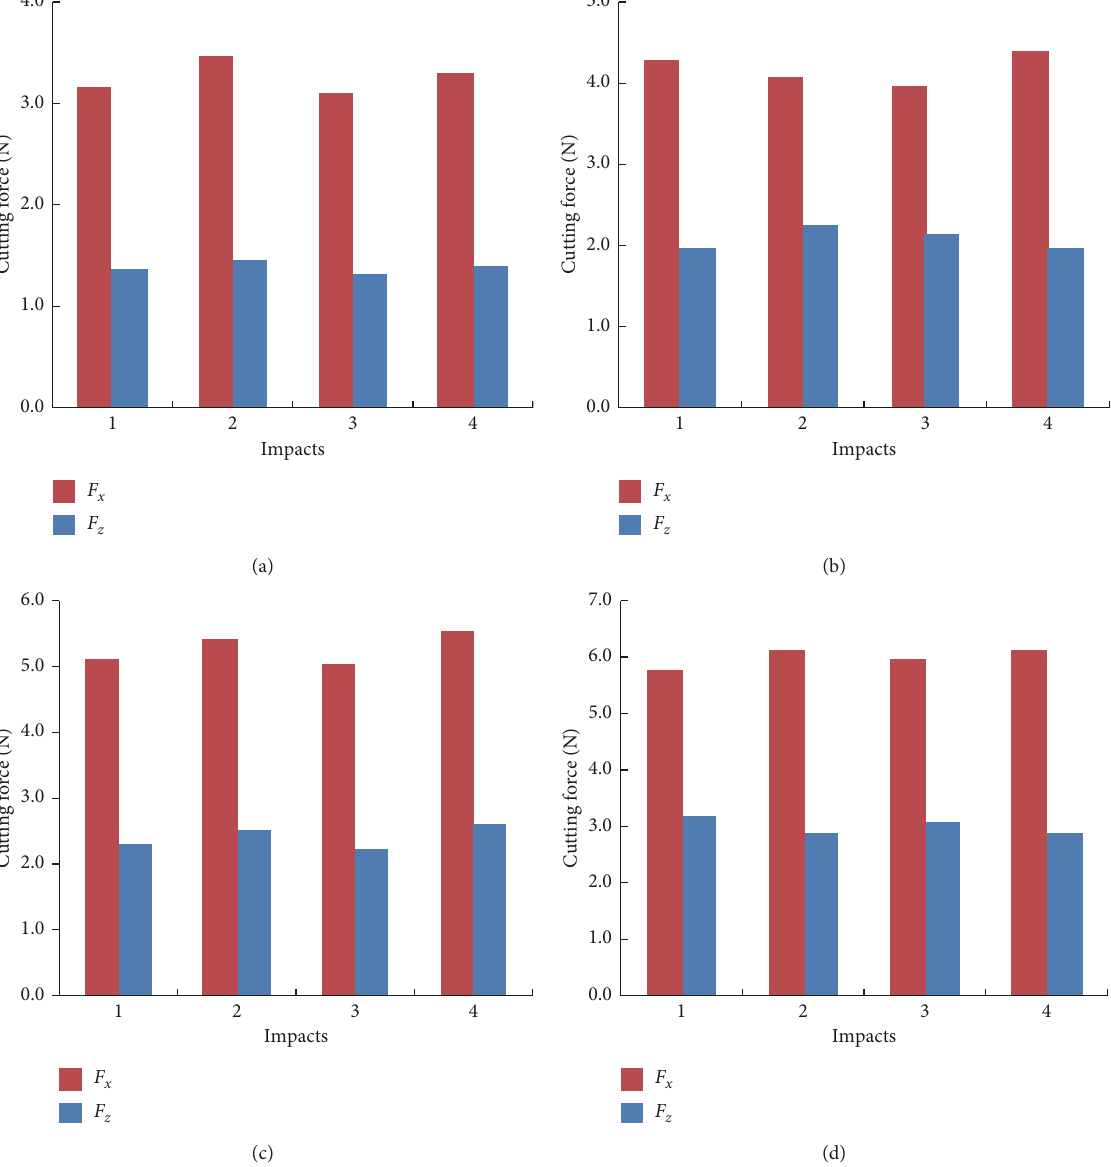
Figure 5: Cutting forces under different cutting depths. (a) a